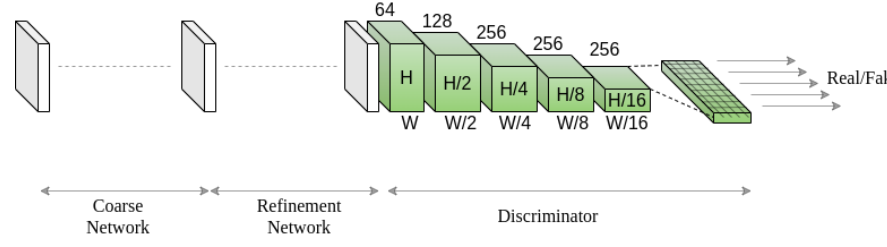
Figure 5. Overview of the discriminator